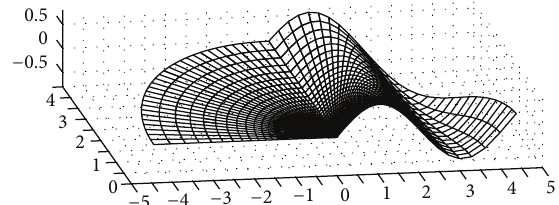
Figure 9: Computational grid in the Cartesian coordinate system with the surface topography with elevation function 𝑧 = 0 when 𝑥 < 0 and 𝑧 = sin (𝑥) when 𝑥 > 0 , 𝑥 ∈ (−4.5; 4.5) .